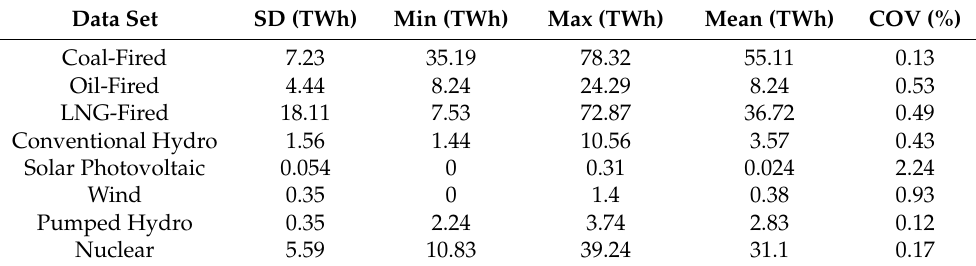
Table 2. Electricity generation statistics for eight types of power generation in Taiwan from 1991 to